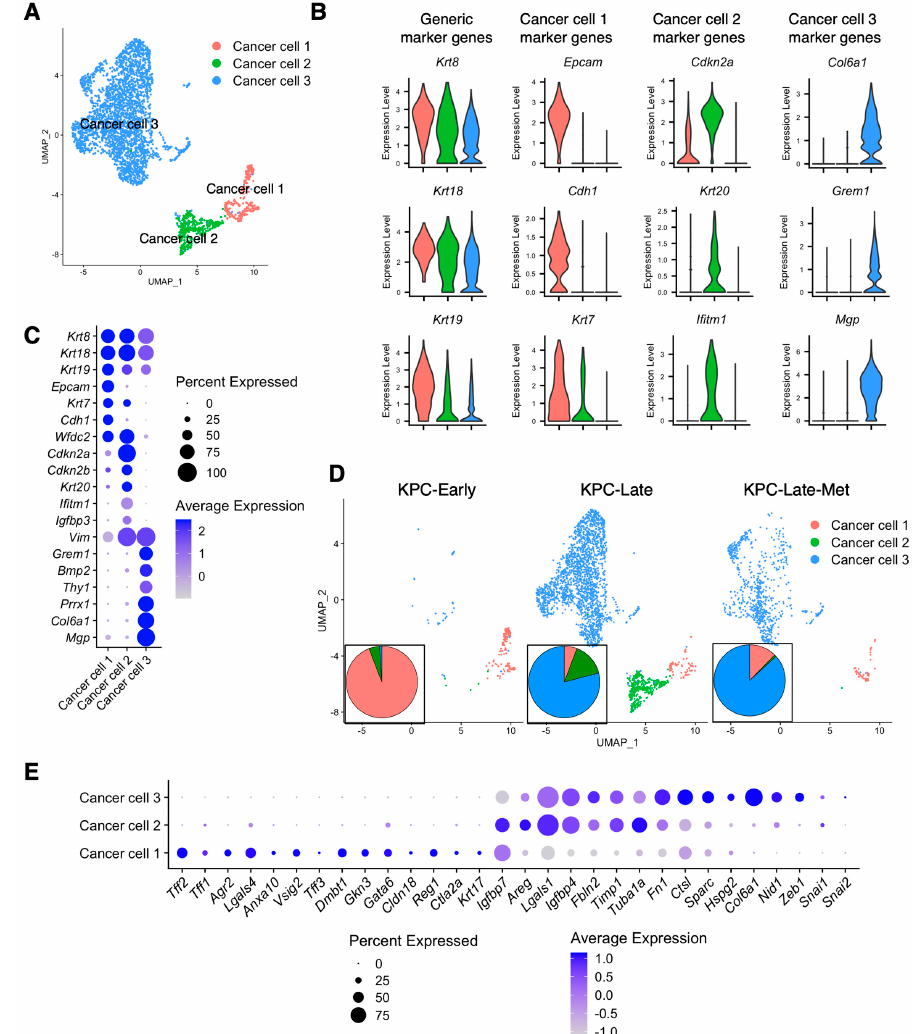
Figure 2. Liver metastases reveal different cancer cell subpopulation compositions from primary tumors. ( A – C ) Cancer cells from primary tumors and liver metastases of KPC-Early, KPC-Late, and KPC-Late-Met groups are stratified into three distinct subclusters in UMAP plot ( A ), based on the various expression profiles of signature genes shown in violin plot ( B ) and dot plot ( C ). ( D ) UMAP plot comparison of the distinct cancer cell subcluster compositions in the primary tumors and liver metastases of KPC-Early, KPC-Late, and KPC-Late-Met groups. The temporal alterations in cancer cell subcluster compositions among three groups are also shown in pie chart plot. ( E ) The cancer cell subclusters were examined for the expression profiles of genes associated with the classical and basal-like cancer cell subtype definition, as shown in dot